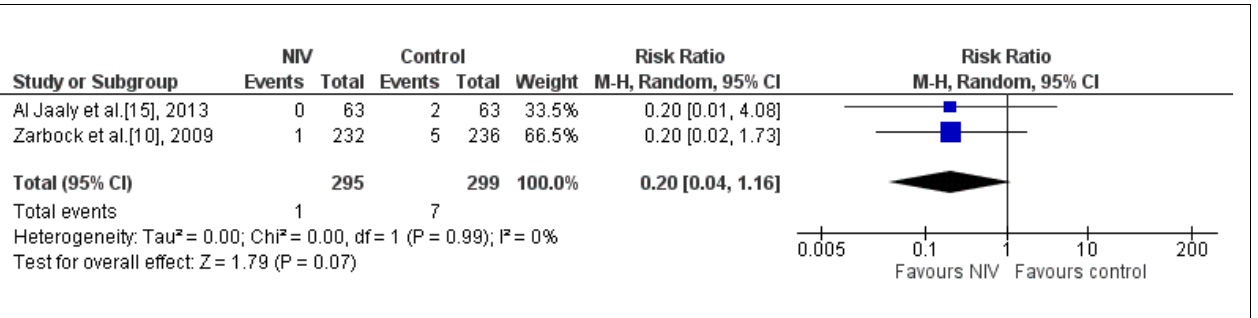
Fig. 3 – Analysis of the pneumonia regarding the studies that compared the prophylactic NIV to the control group. NIV=noninvasive ventilation in the 1 st day of postoperative care (preoperative: control group 78±10, CPAP 76±12, BiLevel 81±10; 1 st day before treatment: control group 65±12, CPAP 63±9, BiLevel 66 ±11; P <0.001).